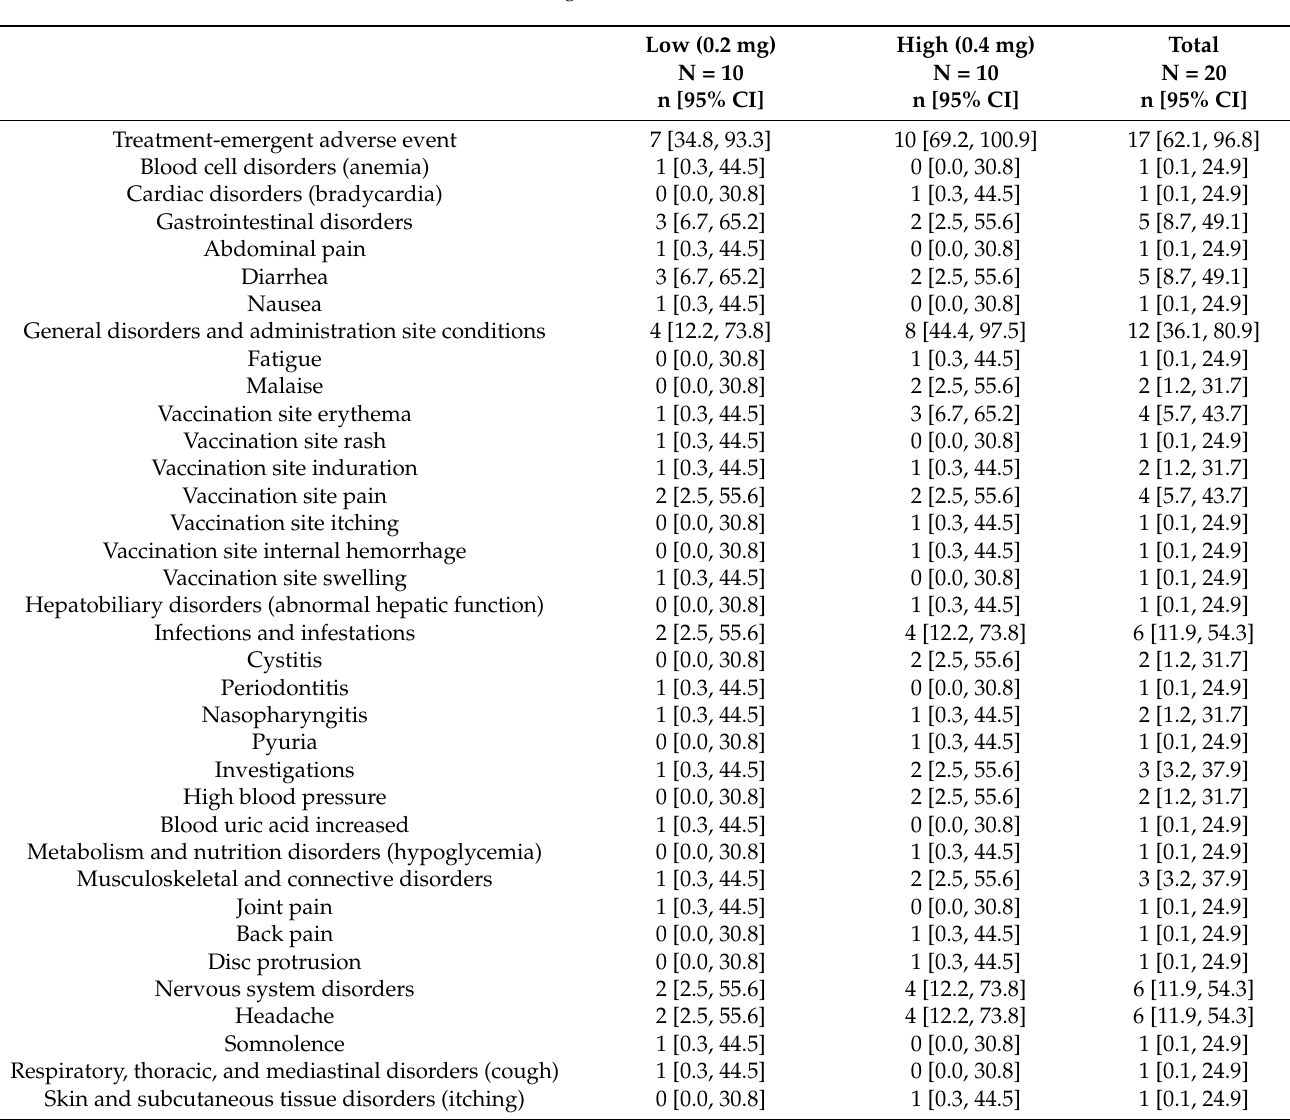
Table 2. Treatment-emergent adverse events.